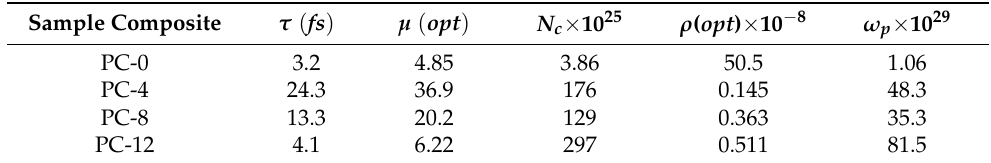
Table 6. Determined values of τ , µ opt , ρ opt , and ω p